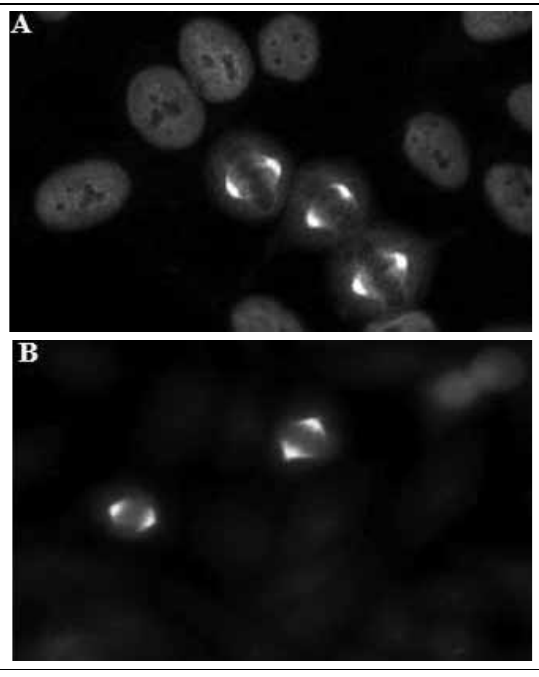
figurE 6 – NuMA-1 and NuMA-2 patterns Upper panel: expected NuMA-2 observed in slides A to G. Lower panel: expected NuMA-2 pattern identified in slides A to G. NuMA-1; nuclear mitotic apparatus protein 1; NuMA-2: nuclear mitotic apparatus protein